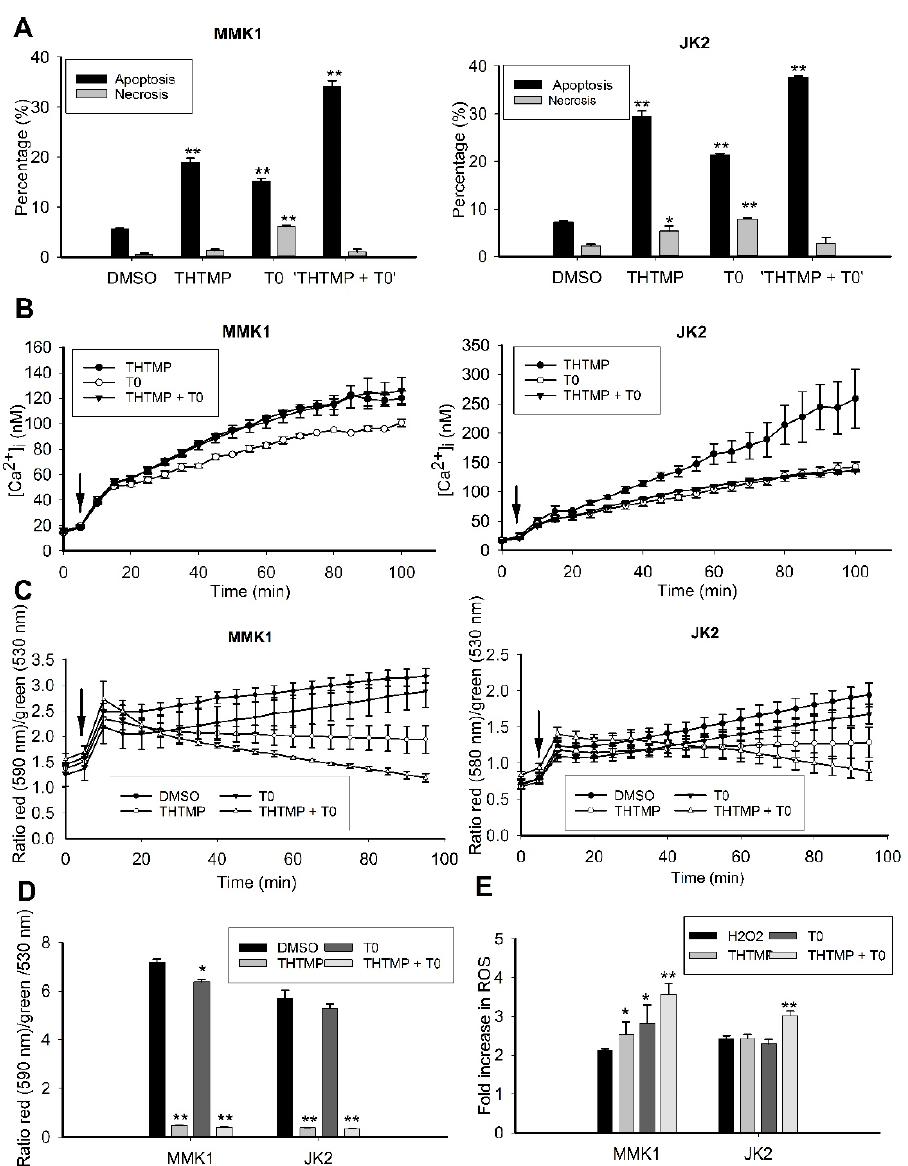
Figure 6. Cell death induction by THTMP, T0 and combination of THTMP + T0 on MMK1 and JK2 cells. Analysis of apoptosis induction in MMK1 and JK2 cells upon THTMP, T0 and THTMP + T0 ( A ). Time course measurement of [Ca 2+ ]i using fluorescence spectrophotometry from Fura-2 loaded cells. Arrows indicate the time of the addition of the compounds ( B ). Change in mitochondrial membrane potential in MMK1 and JK2 cells within 100 min ( C ) and 24 h of treatment ( D ). Arrows indicate the time of the addition of the compounds. Fold change in ROS production ( E ). The data were shown as mean ± SD, n = 3, * p < 0.05, ** p < 0.01. The dissipation of mitochondrial membrane potential is an early indicator of